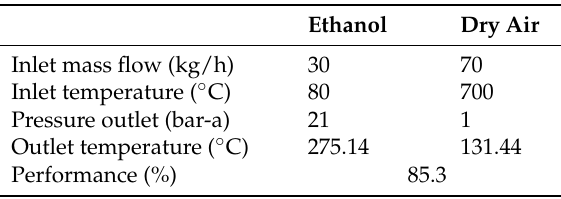
Table 4. Boiler operating conditions.